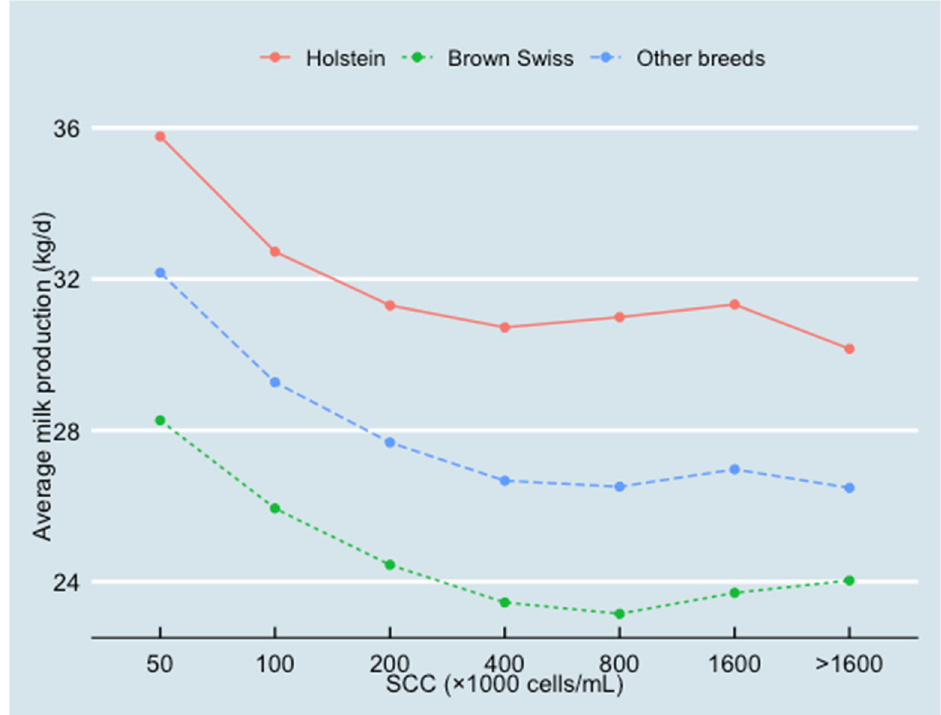
Figure 6. Relationship between SCC and average milk production (10,445,464 test-day records from 826,831 cows in 2970 herds) classified by different breeds (Holstein, Brown Swiss and other breeds).